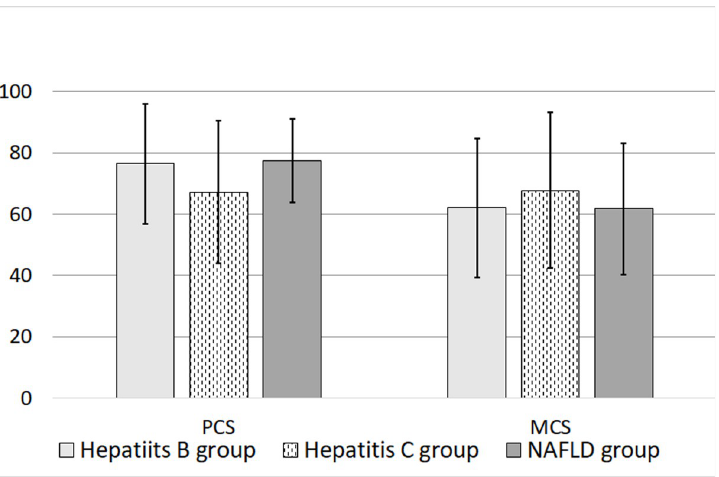
Fig 2. Respective PCS (physical component summary) and MCS (mental component summary) of the three patient groups (mean ± SD).